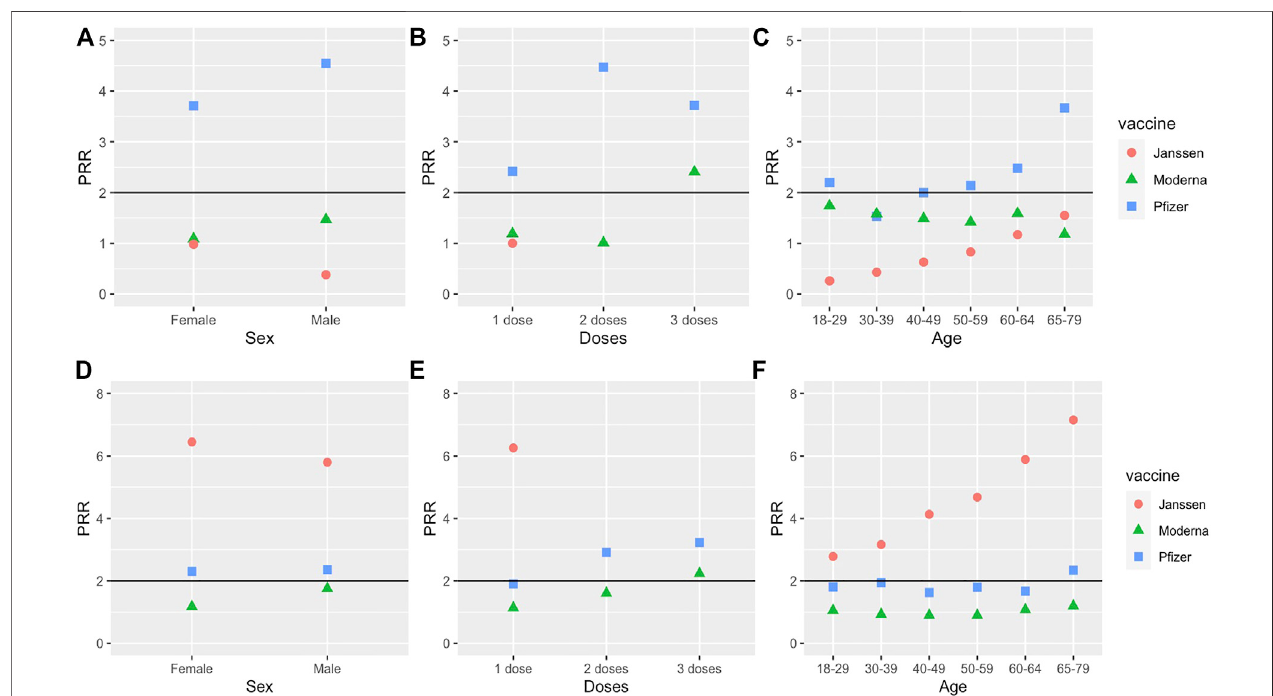
FIGURE 3 | PRRs of myocarditis and thrombosis under 3 conditions (sex, dose number, and age). (A – C) are for myocarditis, and (D – F) are for thrombosis. The effects of sex, dose, and age are studied. Note that we only used Dose 1 data for the Janssen vaccine.